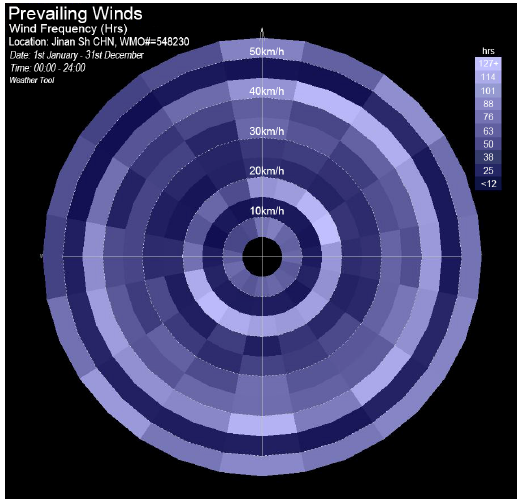
Figure 4. Shandong annual wind frequency chart (latitude 36°52 ′ , longitude 116°14 ′ ). In Figure 5, the first line from top to bottom is the annual maximum temperature distribution curve. The second line is the minimum yearly temperature distribution curve, and the column shows the annual rainfall.